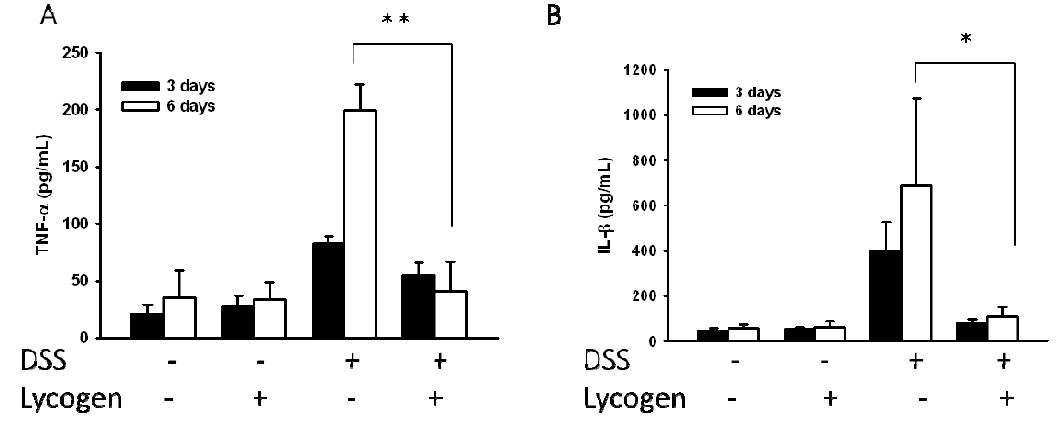
Figure 1. Effects of Lycogen™ on cytokine induction in DSS-induced colitis. The mice with colitis were orally administered with Lycogen™ (1 mg/kg) for six consecutive days after DSS induction. ( A ) TNF- α and ( B ) IL-1 β levels in the sera were measured by ELISA at day 6 (mean ± SD, n = 4). Significance of differences between groups for continuous variables was assessed using the Student t-test.* p < 0.05; ** p < 0.01. Each experiment was repeated three times with similar results.